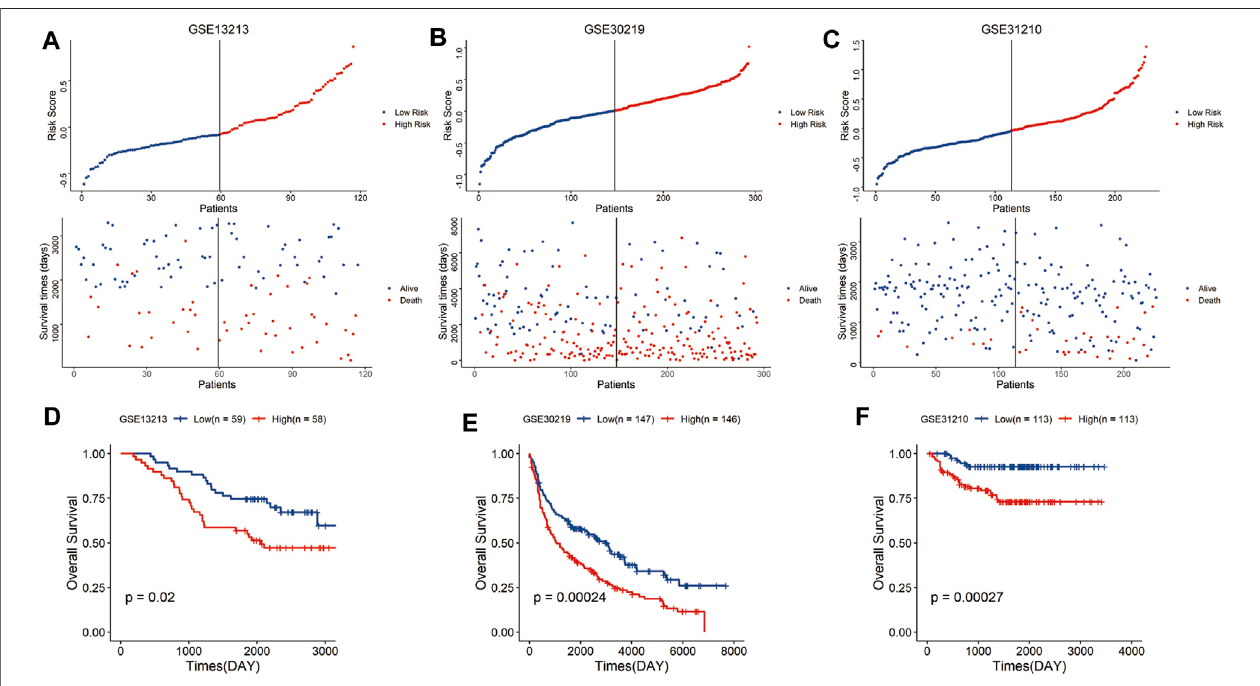
FIGURE3| ValidationoftherisksignatureintheGEOcohort.DistributionoftheriskscoreandsurvivalstatusintheGSE13213 (A) ,GSE30219 (B) ,andGSE31210 cohort (C) . Kaplan – Meier curves of overall survival for patients with LUAD based on the risk score in the GSE13213 (D) , GSE30219 (E) , and GSE31210 cohort (F) .